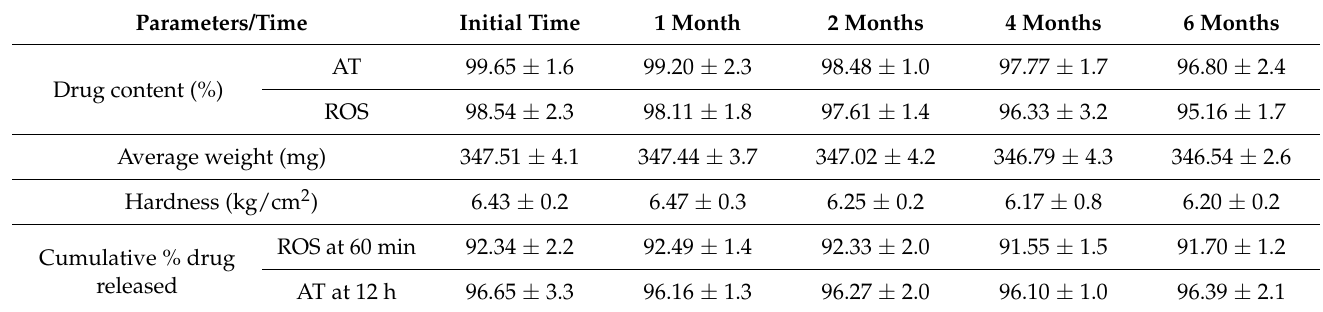
Table 10. AT/ROS BLTs stability study profile.